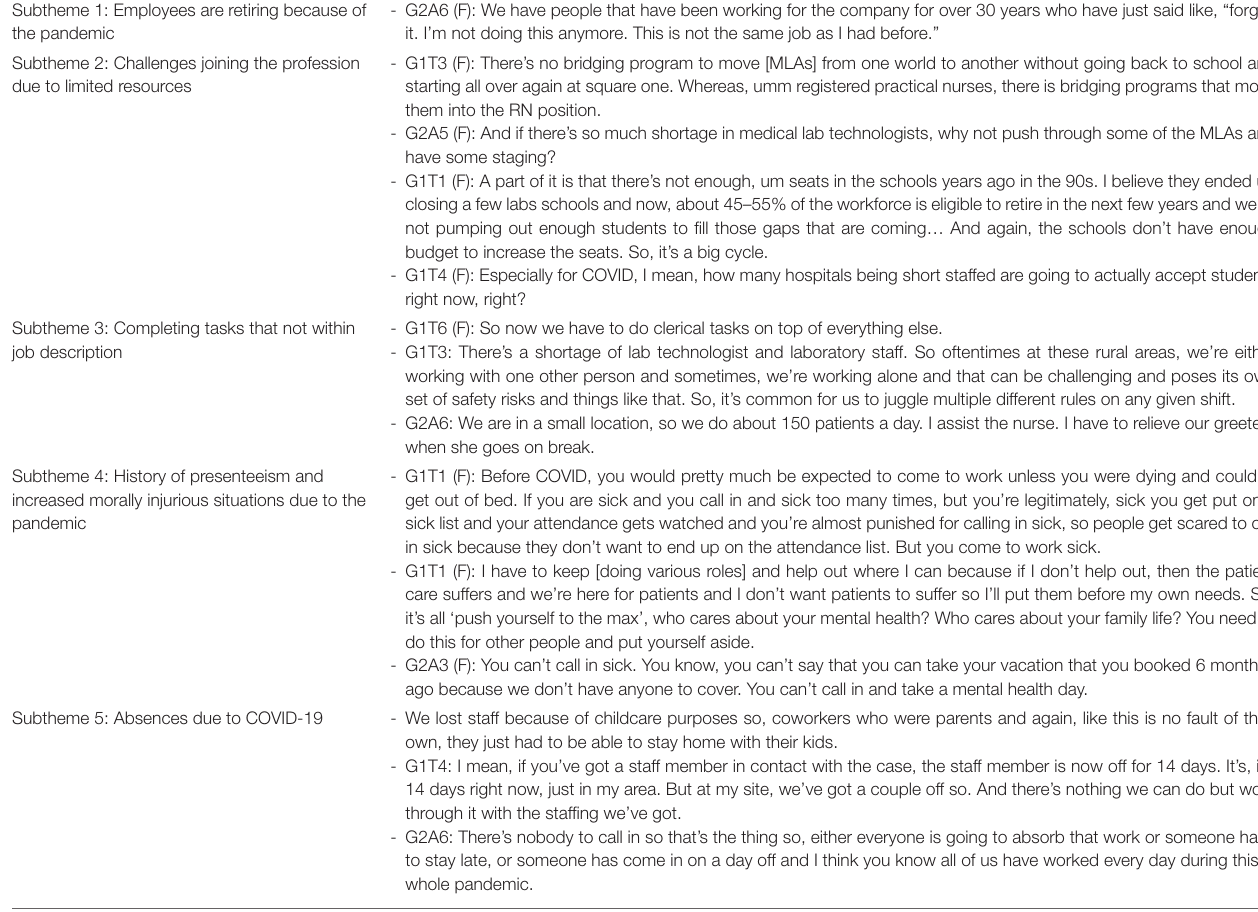
TABLE 3 | Theme 1: COVID-19 Contributing to the notable and existing staff